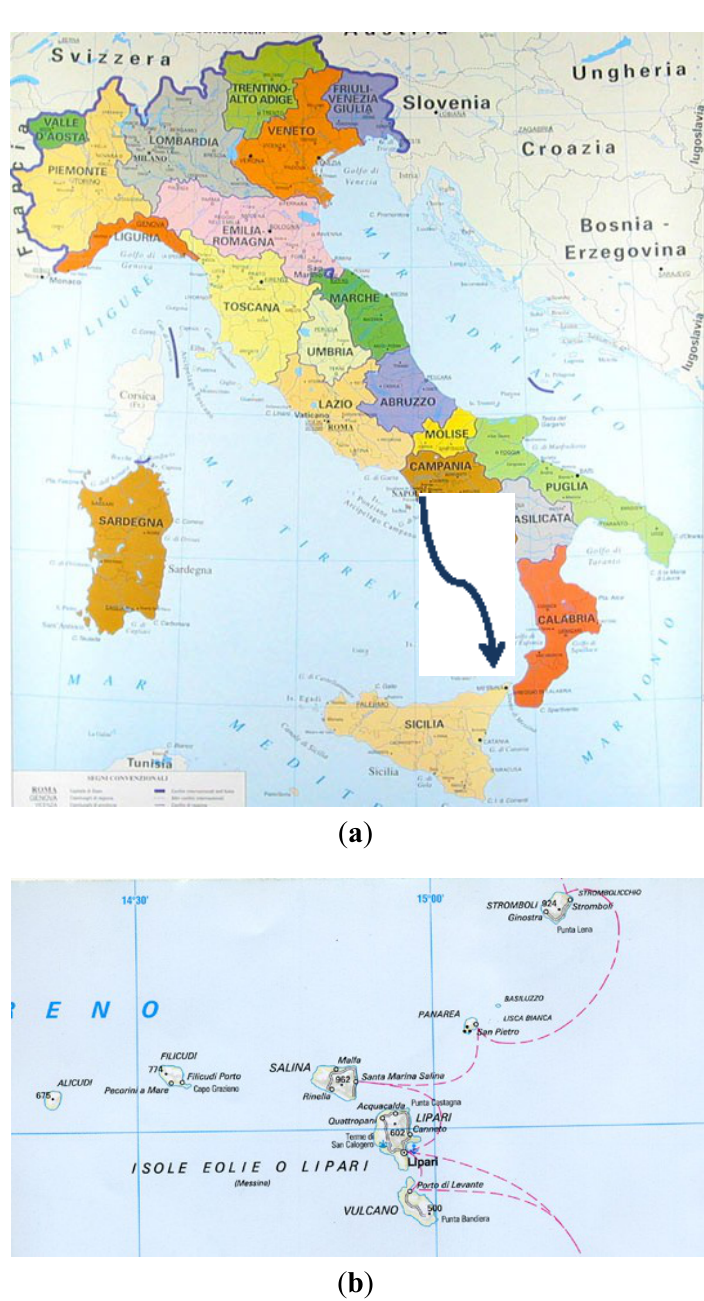
Figure 1. Map of Italy ( a ) Zoom on the Eolian Islands ( b ); The transport route is represented by the